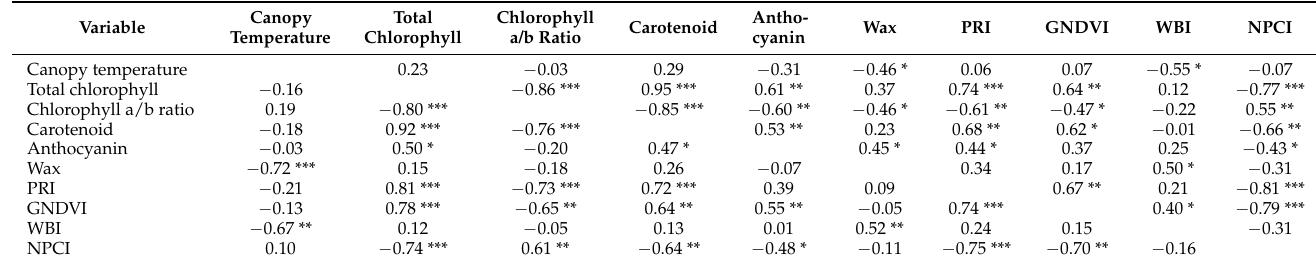
Table 3. Pearson correlation test showing associations among canopy temperature, total chlorophyll, chlorophyll a/b ratio, carotenoid, anthocyanin, wax, photochemical reflectance index (PRI), green normalized vegetation index (GNDVI), water band index (WBI), and normalized pigment chlorophyll ratio index (NPCI) of 24 pea cultivars grown under field conditions under control (upper right diagonal) and stress (lower left diagonal) environments averaged over two environmental levels and four replications. The control conditions are 2014 late seeding date at Rosthern and 2016 normal seeding date at Saskatoon; and the stress conditions are 2015 late seeding date at Rosthern and Saskatoon,